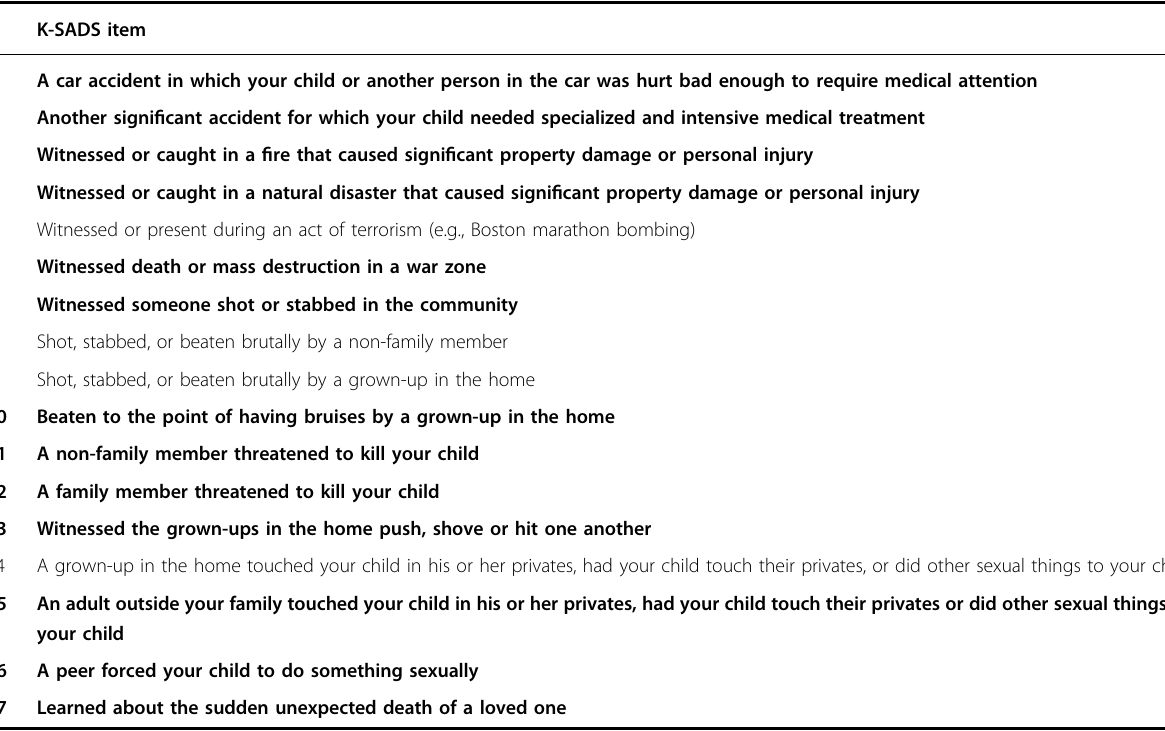
Table 2 Traumatic event items from the Kiddie Schedule for Affective Disorders and Schizophrenia (K-SADS). K-SADS item